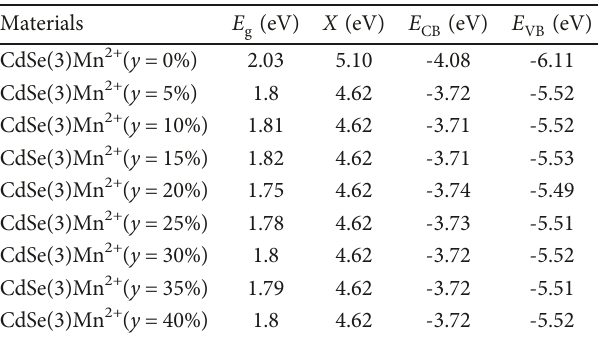
Table 2: The band gap, CB, and VB positions of CdSe:Mn 2+ are calculated by Tauc and UV-Vis spectra.